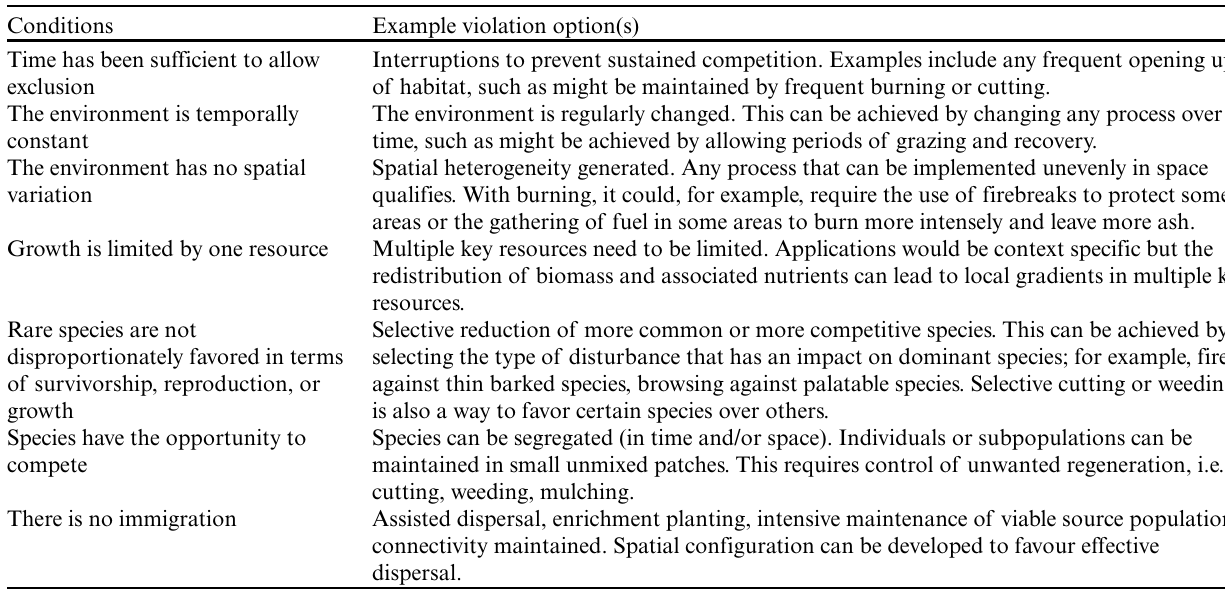
Table 2 . Seven conditions for which violation will slow or prevent competitive exclusion among species with potential violations and options provided through disturbance or other interventions (based on Palmer 1994).